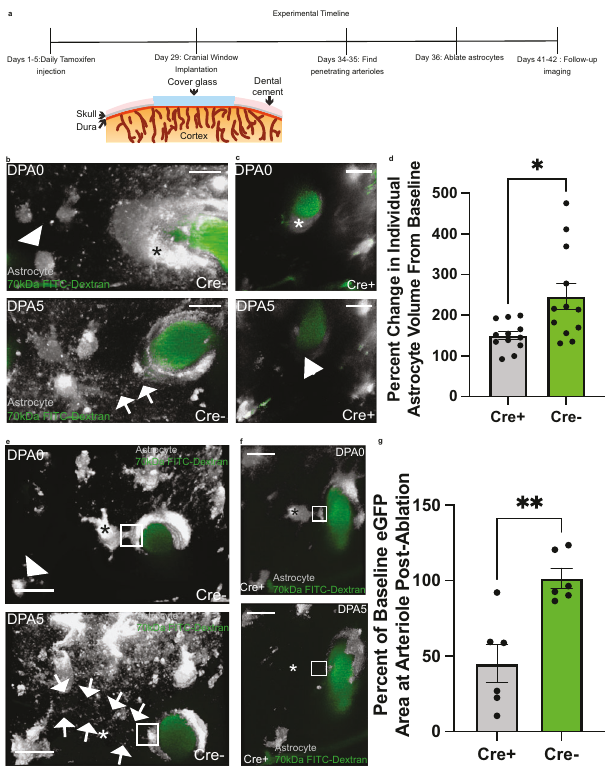
Fig. 6 The genetic ablation of pSTAT3 signi fi cantly reduces the volume of replacement astrocytes and eGFP + area around the vasculature post- ablation. In all images, asterisks indicate the ablated astrocyte(s) (shown in gray, blood vessels are in green) and arrows demarcate replacement processes. Arrowheads indicate which astrocytes at baseline will serve as replacement astrocytes post-ablation. a Cartoon diagram depicting the experimental approach. b Volumetric reconstruction of an astrocyte at a penetrating arteriole in control Cre − mice on (top) day post-ablation 0 (dpa0) and (bottom) day post-ablation fi ve (dpa5), in which a surrounding astrocyte replaces the vacancy left by the previously ablated vessel-associated astrocyte. c Volumetric reconstruction of an astrocyte at a penetrating arteriole in experimental Cre + mice on (top) dpa0 and (bottom) dpa5, in which surrounding astrocytes fail to replace the vacancy left by the previously ablated vessel-associated astrocyte. The box in the bottom image highlights the vacant vascular region. n = 12 astrocytes across 3 mice. d Percent change in individual astrocyte volume from baseline. n = 12 astrocytes across 3 mice for both groups, Two-tailed Unpaired t-test with Welch ’ s correction, p < 0.0144. e Volumetric reconstruction from a dorsolateral view of an astrocyte at a penetrating arteriole in control Cre − mice on (top) dpa0 and (bottom) dpa5, in which a surrounding astrocyte replaces the vacancy left by the previously ablated parenchymal-associated astrocyte. eGFP area around the vessel remains consistent as highlighted in the boxed region. f Volumetric reconstruction of an astrocyte at a penetrating arteriole in experimental Cre + mice on (top) dpa0 and (bottom) dpa5, in which surrounding astrocytes fail to replace the vacancy left by the previously ablated parenchymal-associated astrocyte. The eGFP area around the vessel is signi fi cantly reduced at dpa5, as highlighted by the boxed region. n = 6 astrocytes over 3 mice for both groups. g Percent change in eGFP area around the vessel relative to baseline. n = 6 astrocytes over 3 mice for both groups, Two-tailed Unpaired t-test with Welch ’ s correction, p < 0.0043. Scale bar is 20 µ m in all images. Data are presented as mean values ± SEM. LUTs have been adjusted to emphasize the replacement astrocytes and associated